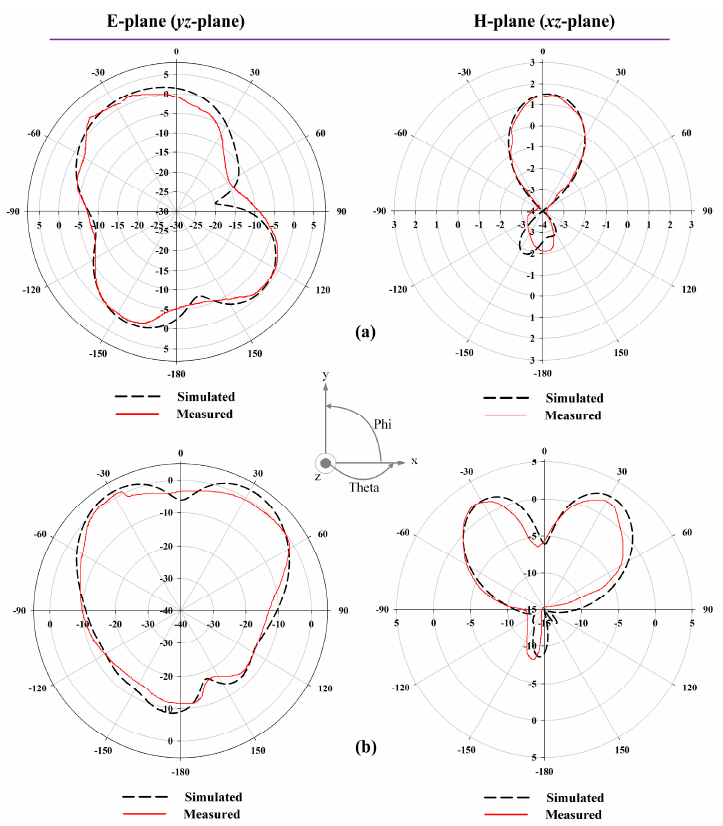
Figure 10. Simulated and measured normalised polar radiation pattern at biasing condition of 13 V (~0.73 pF): ( a ) 3 GHz and ( b ) 6.5 GHz.